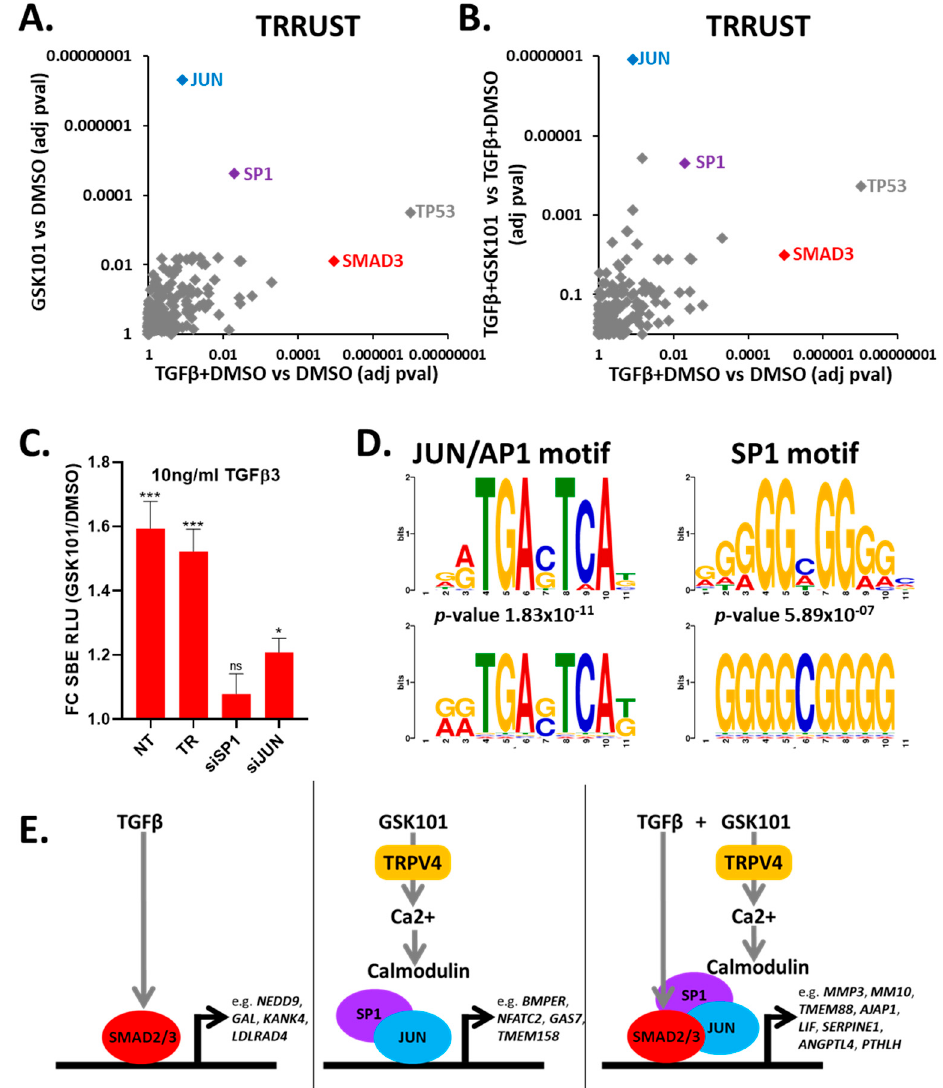
Figure 5. TRPV4 activation enhances TGF β signalling through the JUN and SP1 transcription factors. ( A , B ) TRRUST analysis of genes significantly increased in RNAseq for each of the indicated experimental comparisons. ( C ) siRNA knockdown of JUN and SP1 prevents TRPV4 enhancement of TGF β signalling. Data were combined from three independent experiments. GSK101 treatment was normalised to DMSO for each siRNA. Statistical differences were calculated using two-way ANOVA followed by Sidak’s multiple comparisons test; p < 0.05 * and p < 0.001 ***. FC SBE RLU; fold change in SMAD-binding element relative light units. ( D ) Sequence motif logos of JUN (MA0490.1; p -value 1.83 × 10 − 11 ) and SP1 (MA0079.3.1; p -value 5.89 × 10 − 7 ) within upregulated genes following TRPV4 activation created by TOMTOM from JASPAR2018_CORE_vertebrates_non-redundant database. ( E ) Schematic representation of possible mode of action of TGF β and GSK101. In the presence of only TGF β , SMAD2/3 causes transcriptional response of TGF β target genes. In the presence of only GSK101, TRPV4 is activated, causing increased intracellular calcium, leading to activation of TRPV4 response genes. When TGF β stimulation is followed by TRPV4 activation after 15 min, TGF β activates SMAD3, and then TRPV4 activation causes increased calcium, enhancing the effect of TGF β , through a mechanism involving SP1 and JUN, which are known SMAD3-binding partners. NT, no treatment; TR, transfection reagent control.